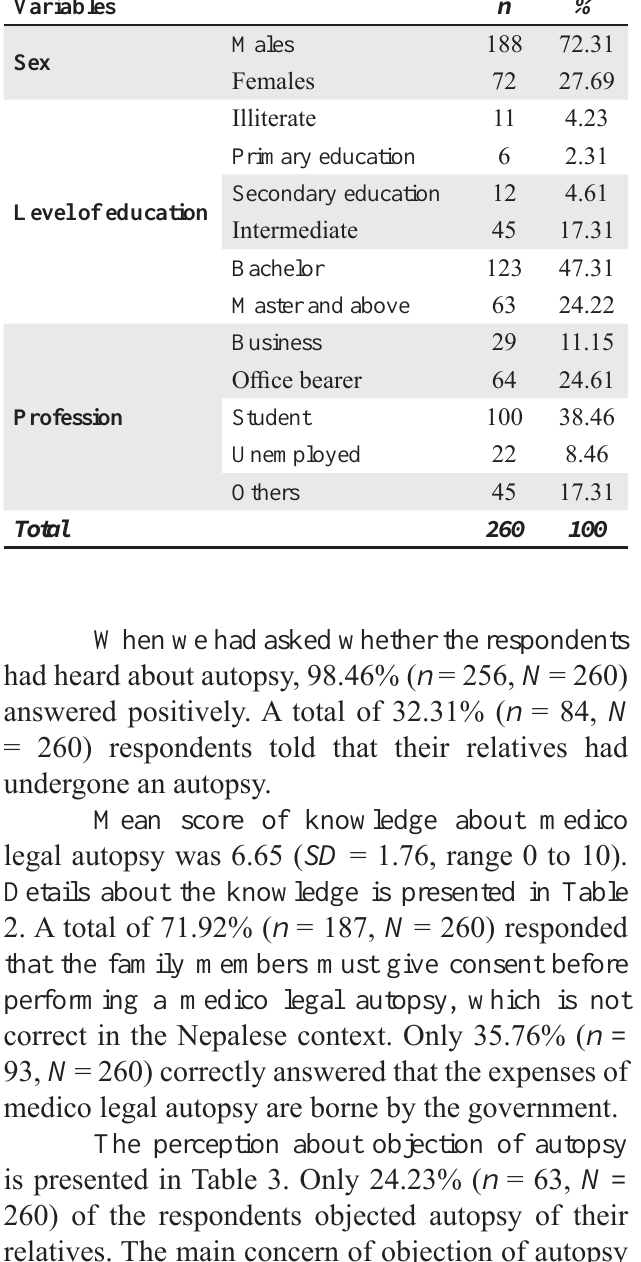
Table 1 : Demographics of the participants